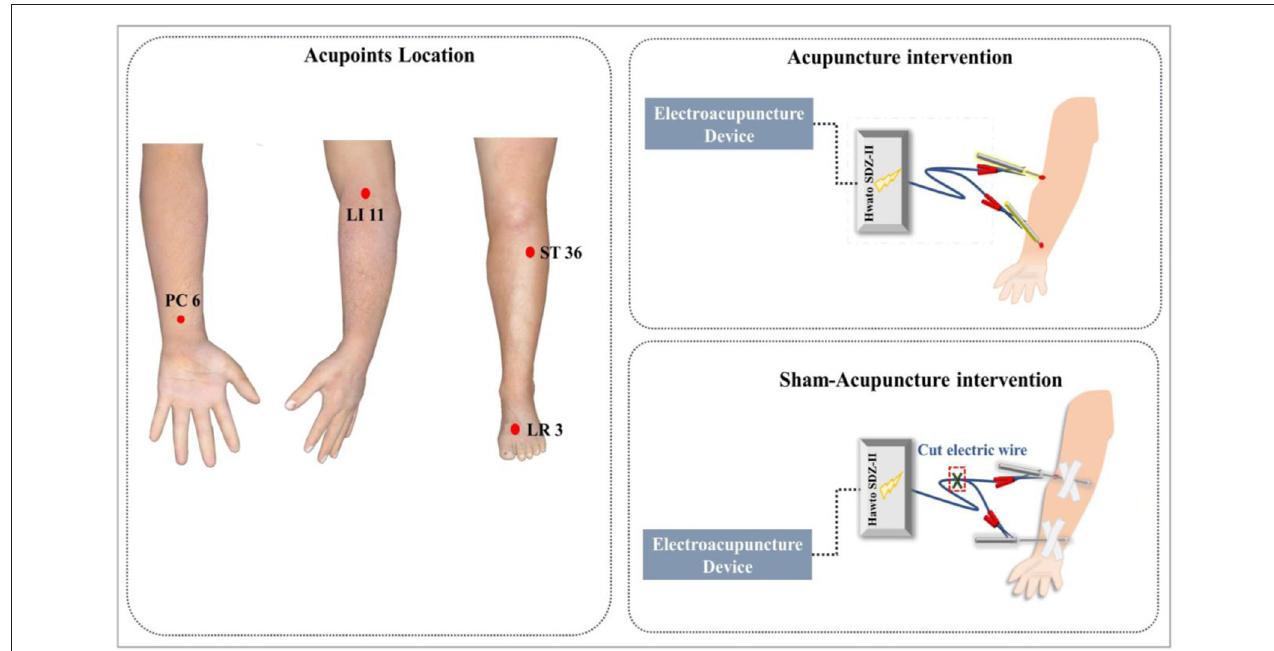
FIGURE 2 | Acupoints Location, acupuncture intervention and sham-acupuncture